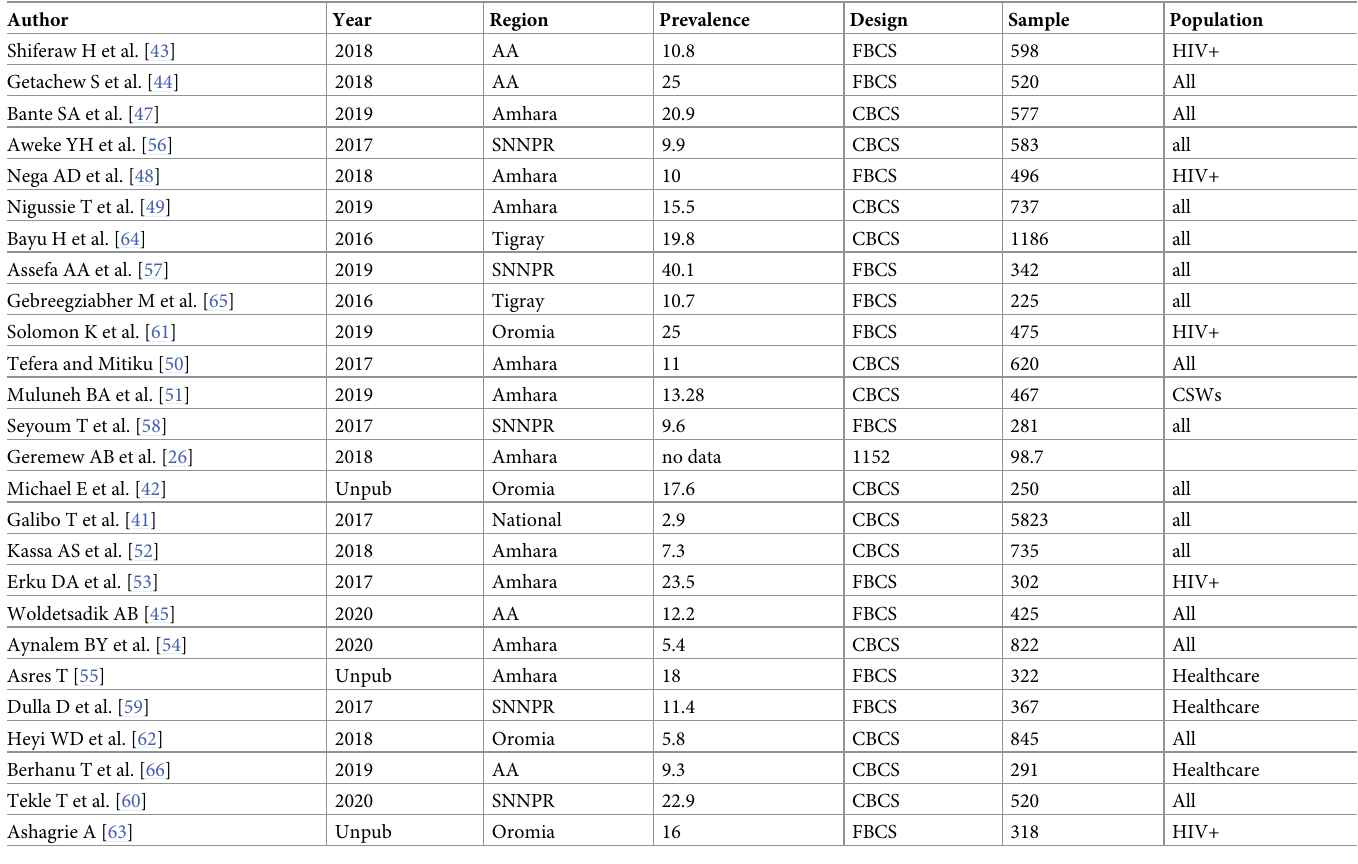
Table 1. Characteristics of the included studies in the meta-analysis,